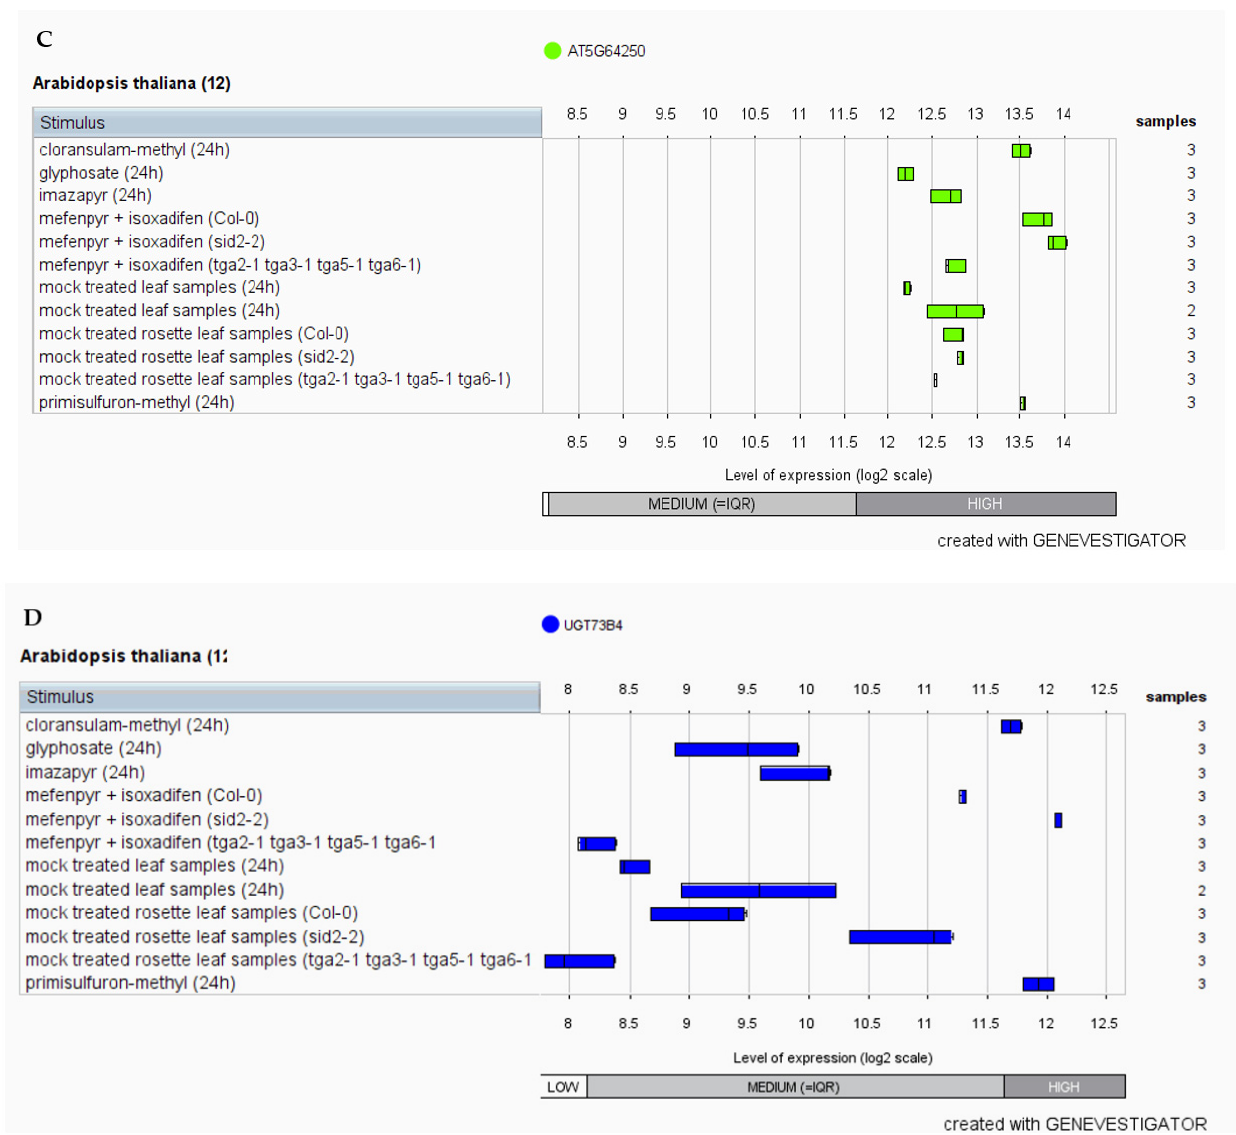
Figure 5. The expression profile of CYP72A14 ( A ), GSTU1 , GSTU8 , GSTU18 , GSTU19 , GSTF6 , and GSTF11 ( B ), NMO gene AT5G64250 ( C ), UDPGT gene UGT73B4 ( D ) under herbicide stress using the software Genevestigator. The level of expression is provided in the log2 scale. The details of herbicide used, rate of applications, and NCBI Accession no. are provided in Supplementary Table